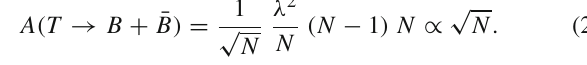
B is the operator B with q a suppressed, where B a = ∂ ∂ q a ¯ B a with ¯ q a and the sum over a = 1 , . . . N is similarly for